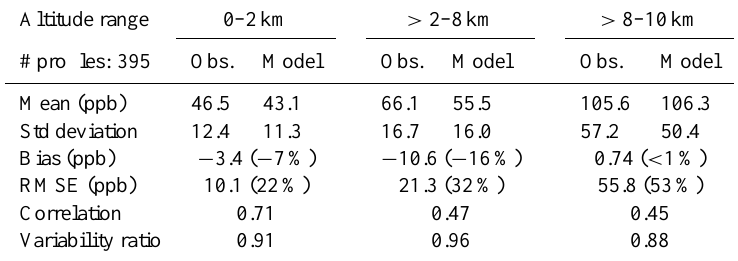
Table 3. Mean ozone concentrations (ppb) and standard deviation have been calculated (over the 3 month period of summer 2008) for observations and models (forced by IFS-MOZART) for all profiles and for 3 altitude ranges: (1) 0–2km; (2) > 2–8km; > 8–10km. Mean bias, RMSE and Pearson’s correlation coefficient are also